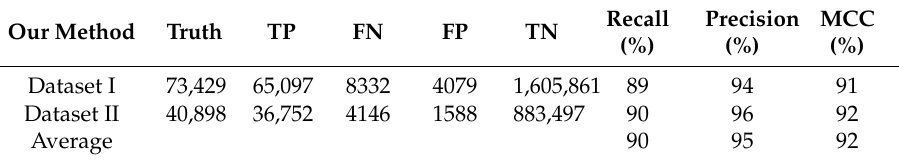
Table 2. Quantitative evaluation of road marking extraction using our method.